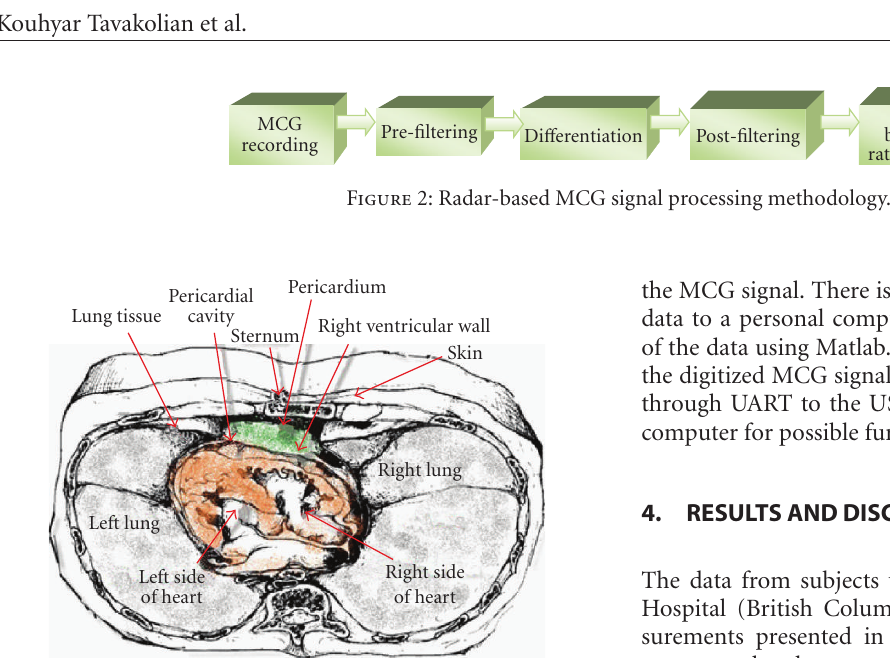
Figure 3: Positioning of di ff erent layers of tissues that the radar signal will go through. The layers between sternum and right ventricle include pericardium, pericardial cavity, and thin layers of pleural tissues.